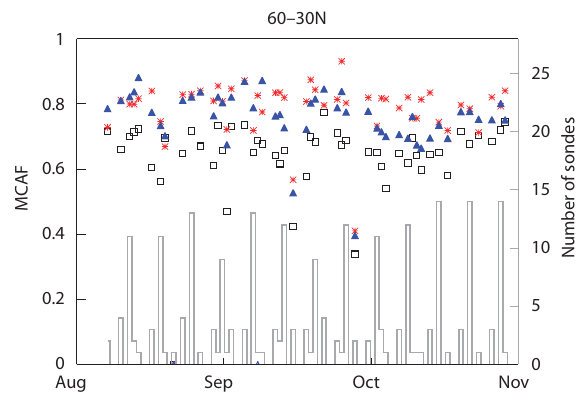
Figure 10. Time series of the stratospheric contribution (considered as that at pressure levels lower than 100hPa) to the mean common area fraction (MCAF) score computed for different sonde profiles and the three sets of ozone analyses. The analyses were taken from Exp/Ctrl (black squares) and the two Exp/PERT experiments, as- similating also the reprocessed GOME-2 NPO 3 (red asterisks) and MIPAS LPO 3 (blue triangles). The plot refers to the midlatitudes in the NH. The grey histogram shows the number of daily sondes included in the MCAF score and refers to the right-hand side axis.